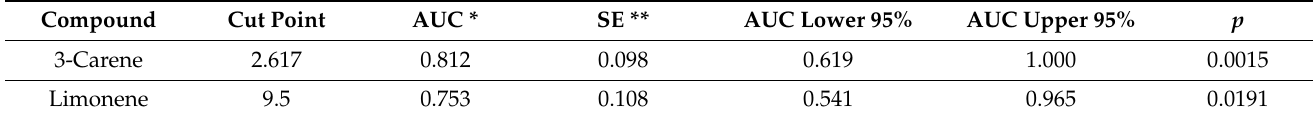
Table 5. Statistical evaluation of the differences between concentrations of VOCs emitted by brood taken from healthy and infected with P. larvae colonies. In both types of samples, the brood showed no clinical signs of P. larvae infection. Results for the ROC analysis.